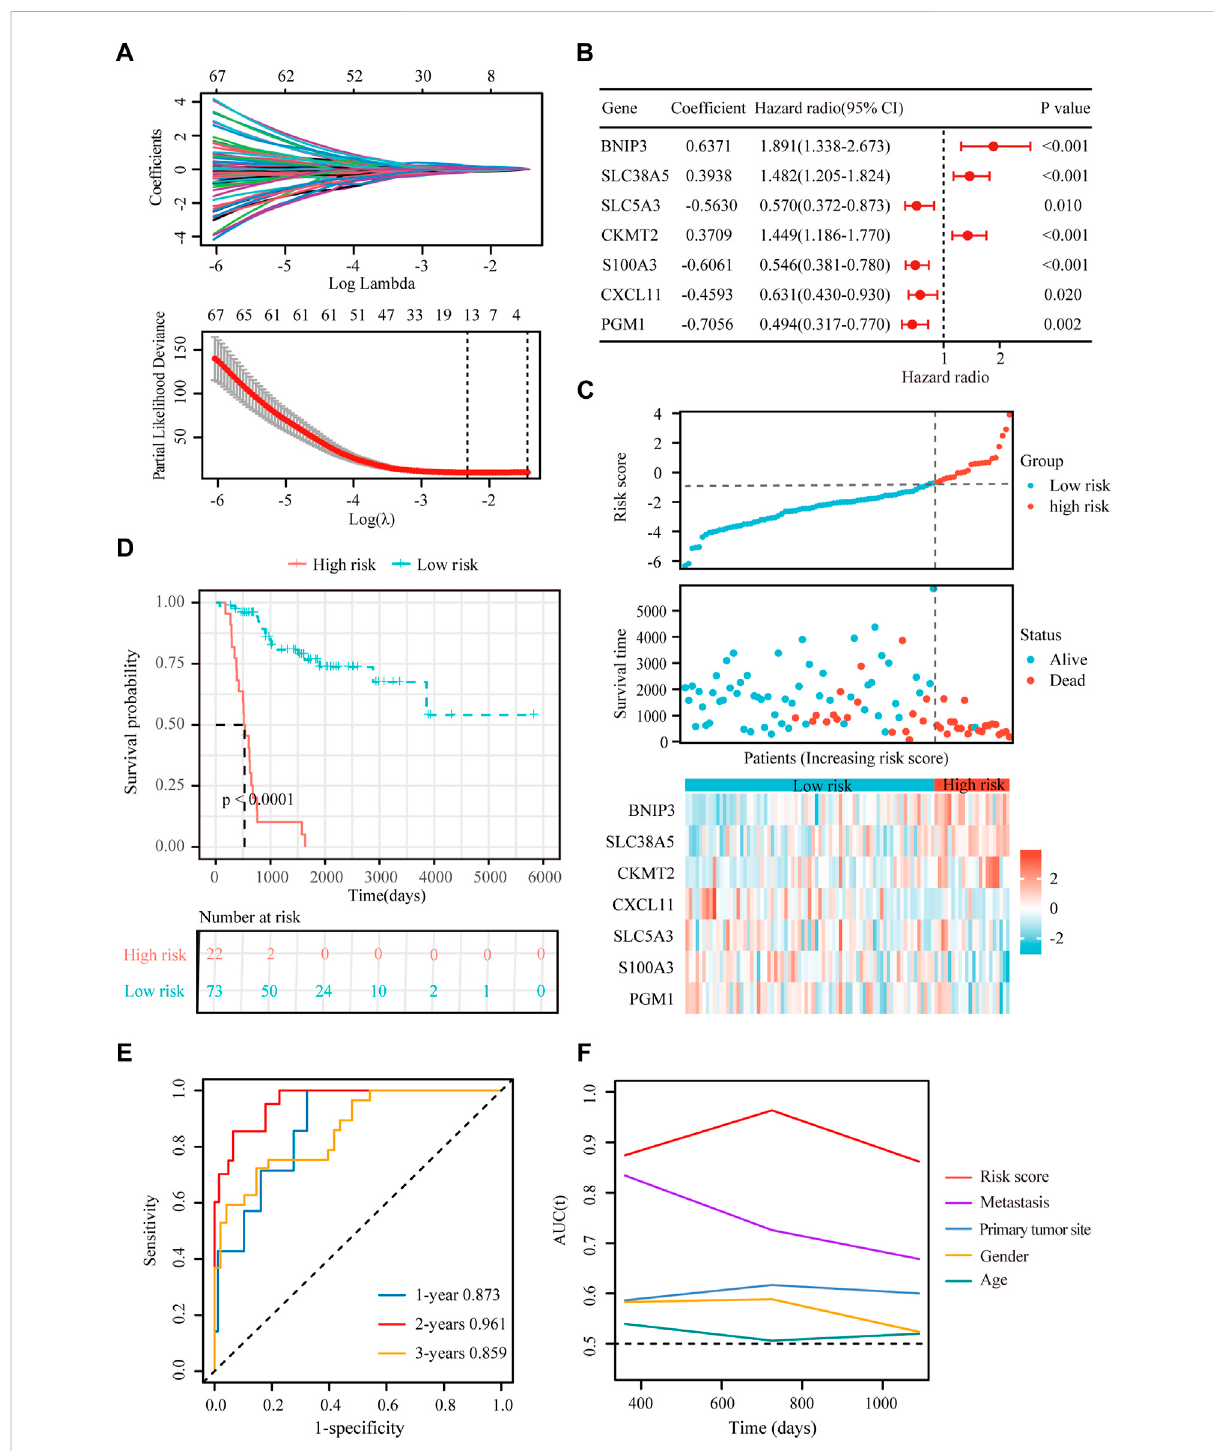
FIGURE 4 Construction of a hypoxia-immune-related prognostic signature. (A) Lasso coef fi cient pro fi les of the most relevant prognostic genes (upper panel) and ten-fold cross validation for tuning parameter selection in the Lasso model (lower panel) in the TARGET dataset. (B) Forest plots of seven DEGs with p < 0.5 bystepwise Cox proportional hazards regression model from theTARGETdataset. (C) Risk score, survival status and expressionof the seven signature genes in the training cohort from TARGET database. (D) K-M curve of overall survival for patients in the high-risk and low- risk groups in the training cohort from TARGET database. (E) Receiver operating characteristic (ROC) curve for 1-, 2-, and 3-year overall survival in patients from TARGET dataset. (F) Comparisons of AUC values among different clinical characteristics of patients in the TARGET dataset.